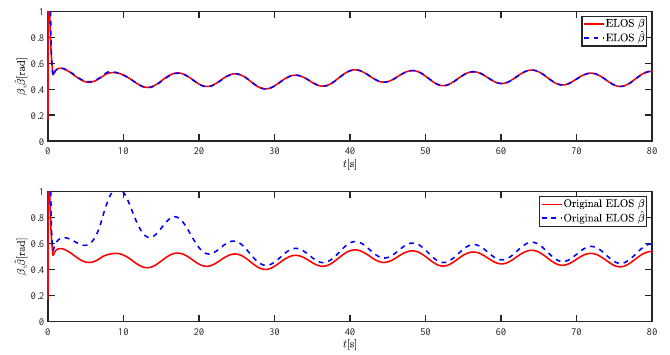
Figure 17. Along-track error x e and cross-track error y e at moderate speed.